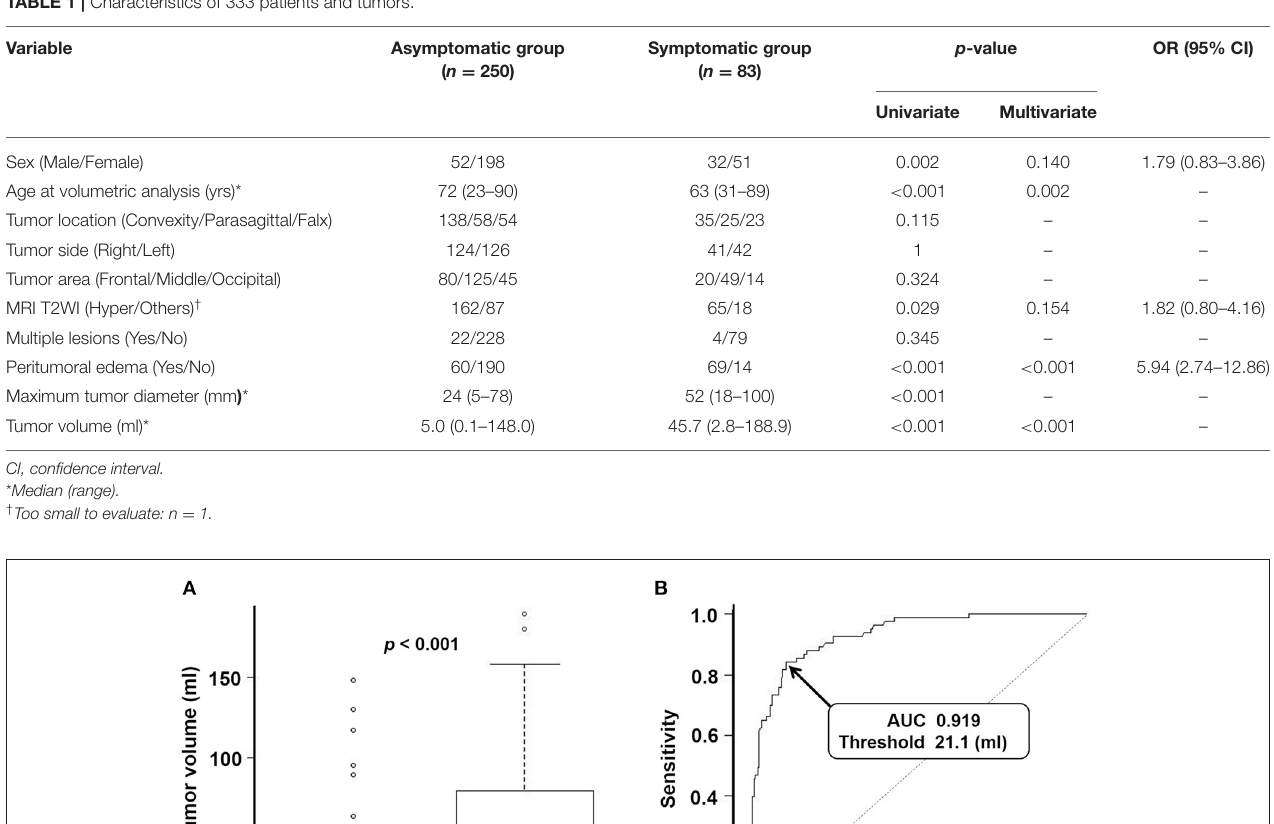
TABLE 1 | Characteristics of 333 patients and tumors.